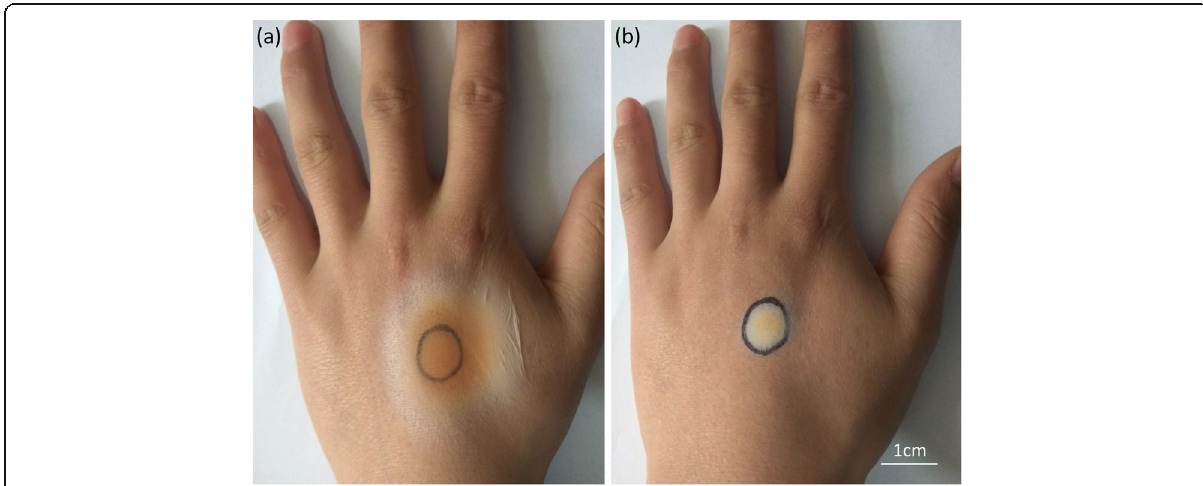
Fig. 9 Schematic of in situ electrospun magnetic fibrous membrane on the surface of hand a without an auxiliary electrode and b with an auxiliary